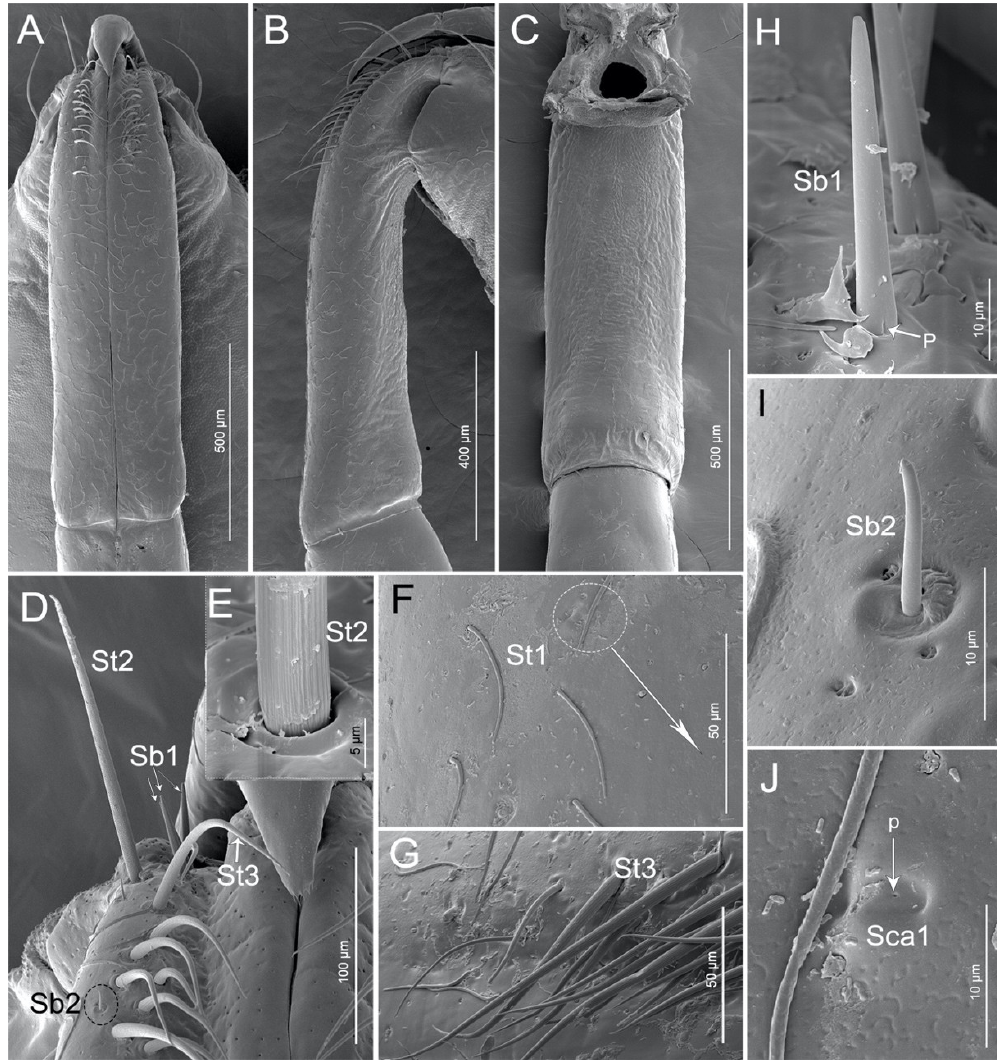
Figure 3. SEM of second labial segment of Haematoloecha nigrorufa . ( A ). Ventral view; ( B ). Lateral view; ( C ). Dorsal view; ( D ). Base of the second segment showing sensilla trichodea (St2), sensilla trichodea (St3), sensilla basiconica (Sb1) and sensilla basiconica (Sb2); ( E ). Base view of sensillum trichodeum (St2); ( F ). Enlarged view of dorsal surface of labium showing sensilla campaniformia (Sca1) and sensilla trichodea (St1); ( G ). Sensilla trichodea (St3); ( H ). Sensilla basiconica (Sb1); ( I ). Sensilla basiconica (Sb2); ( J ). Sensilla campaniformia (Sca1); p , pore. Thirteen types of sensilla were found on this segment, including three types of sensilla trichodea (St1, St2, and St4), five types of sensilla basiconica (Sb1, Sb3, Sb4, Sb5, and Sb6), three types of sensilla campaniformia (Sca1, Sca2, and Sca3), one type of sensilla placoid elongated (Spe), and one type of multilobular sensilla (Sm). There are many sensilla trichodea (St1) and multilobular sensilla (Sm) all over the segment IV dorsal, lateral, and ventral surfaces (Figure 5A–H). Five pairs of sensilla trichodea (St2) are found on segment IV (two pairs on the ventral surface, one pair on the lateral surface, and two pairs on the dorsal surface). Six pairs of sensilla trichodea (St4) are distributed on the proximal part of the fourth segment (Figure 5E). One pair of sensilla basiconica (Sb1) is distributed between the third and fourth labial segments (Figure 5A). Four pairs of sensilla basiconica (Sb3) are found on the distal part of the ventral surface (Figure 5D,E). Eight pairs of sensilla campaniformia (Sca1) are distributed on the proximal position of the last segment (one pair on the ventral surface, two pairs on the lateral surface, and five pairs on the dorsal surface) (Figure 5D,E,G, and Figure